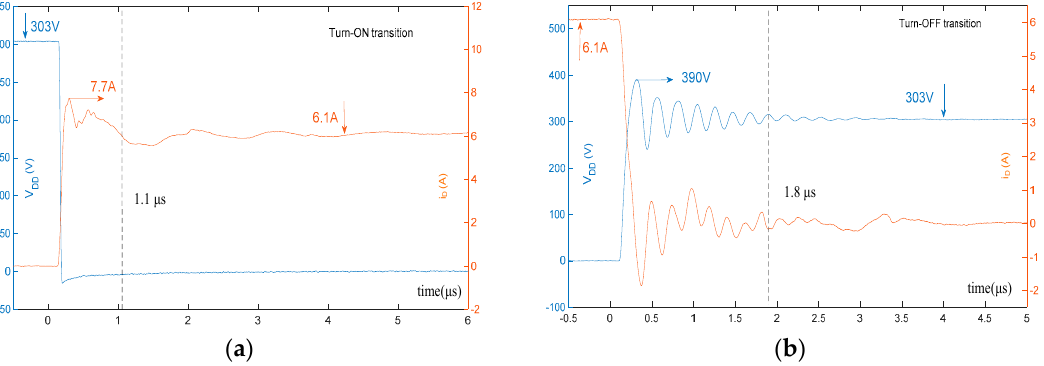
Figure 19. Switching transient under the condition of V in = 303 V, I L = 6.1 A, C X = 0.68 nF. ( a ) Turn-on transient with ferrite ring and C J ; ( b ) Turn-off transient with ferrite ring and C J .